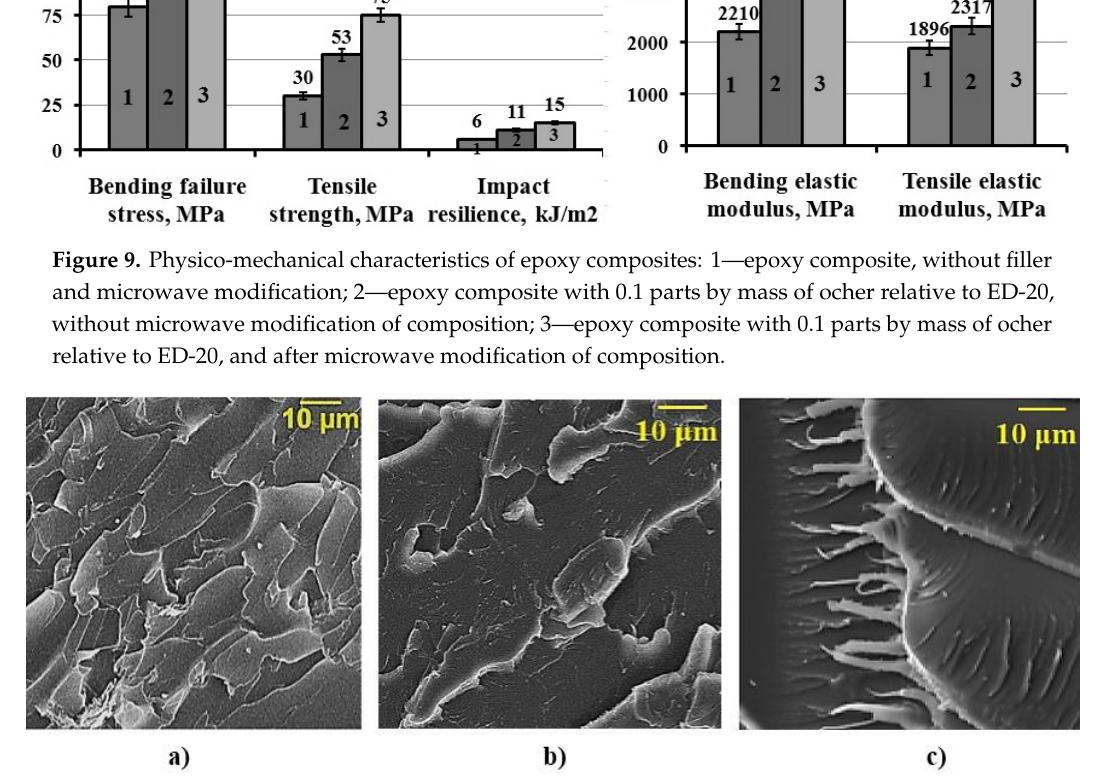
Figure 10. SEM of the surface of the destruction of epoxy composites: ( a )—without microwave modification; ( b , c )—after microwave modification.